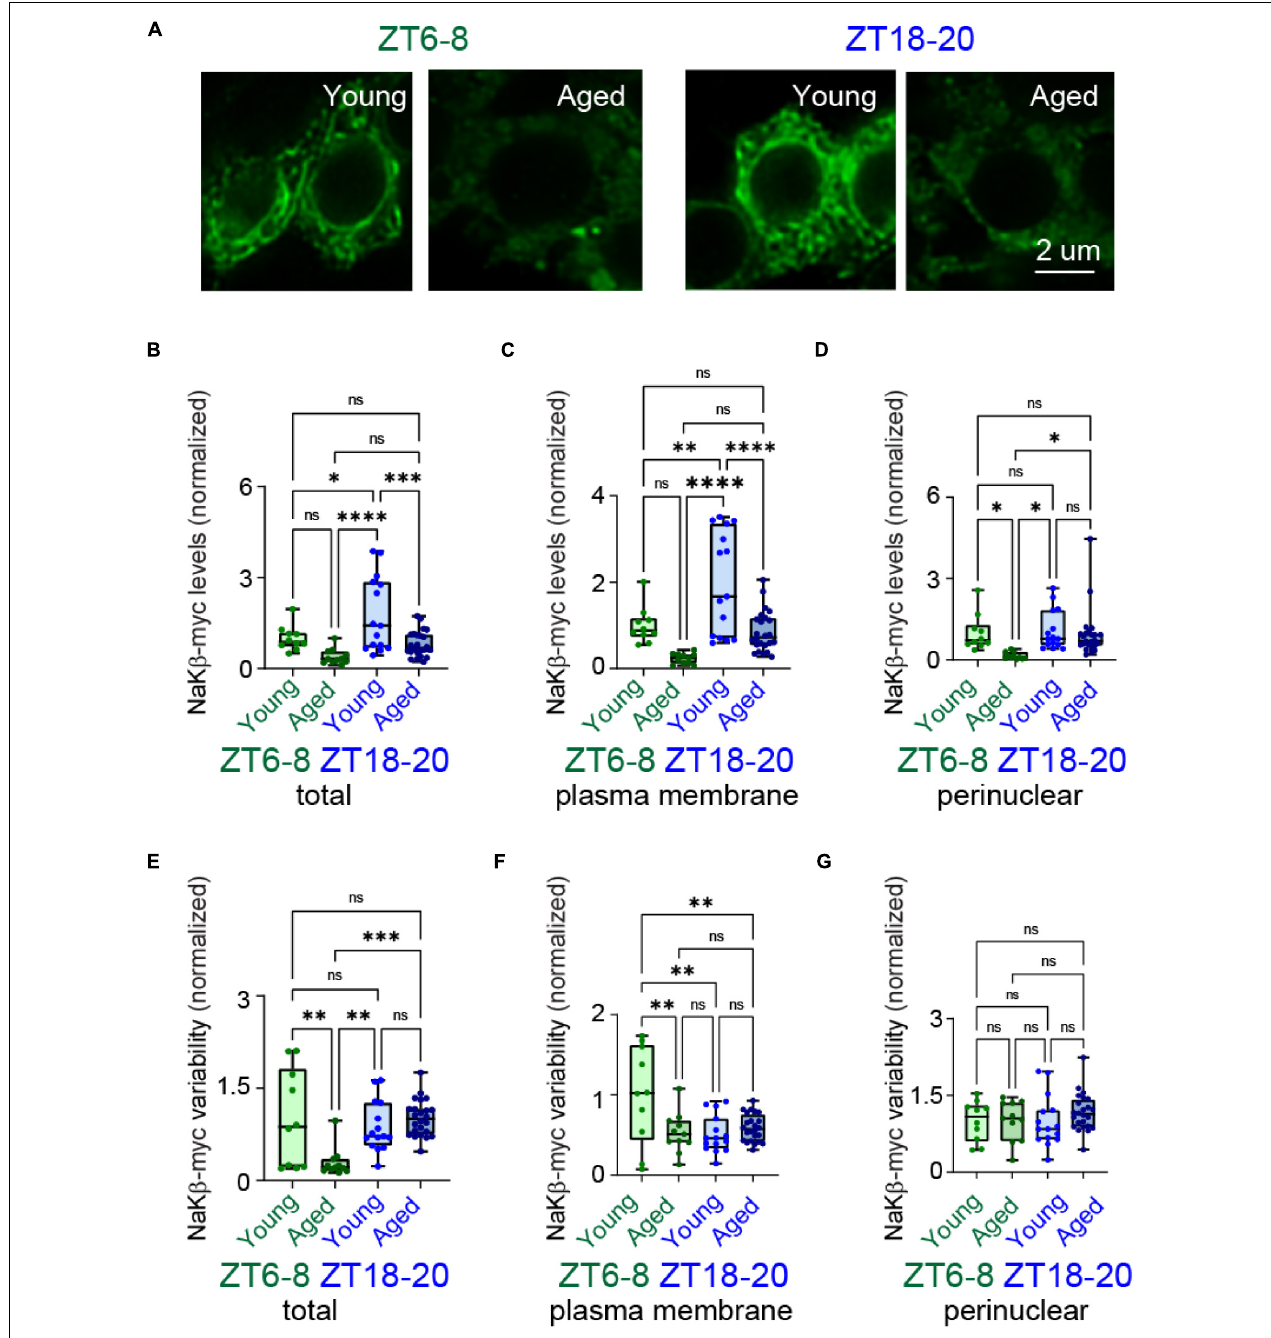
FIGURE 6 | Aging changed time-dependent localization patterns of NaK β in DN1p neurons. (A) Anti-myc (green) immunostaining of DN1p neurons in young and aged wake-GAL4 > UAS-NaK β -myc flies at ZT6–8 and ZT18–20. Scale bar indicates 2 µ m. (B–D) Quantification of total (B) , plasma membrane (C) , and perinuclear (D) NaK β -myc levels in young vs. aged DN1p neurons at ZT6–8 and ZT18–20. (E–G) Quantification of distribution variability for total (E) , plasma membrane (F) , and perinuclear (G) NaK β -myc signals in young vs. aged DN1p neurons at ZT6–8 and ZT18–20 (ZT6–8, young: n = 10, aged: n = 11; ZT18–20, young: n = 15, aged: n = 24). ∗ p < 0.05, ∗∗ p < 0.01, ∗∗∗ p < 0.001, and ∗∗∗∗ p < 0.0001 based on two-way ANOVA with multiple